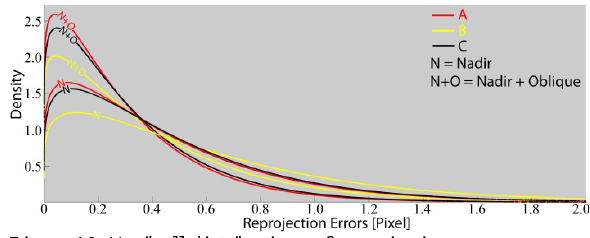
Figure 10: Weibull distributions of reprojection errors.